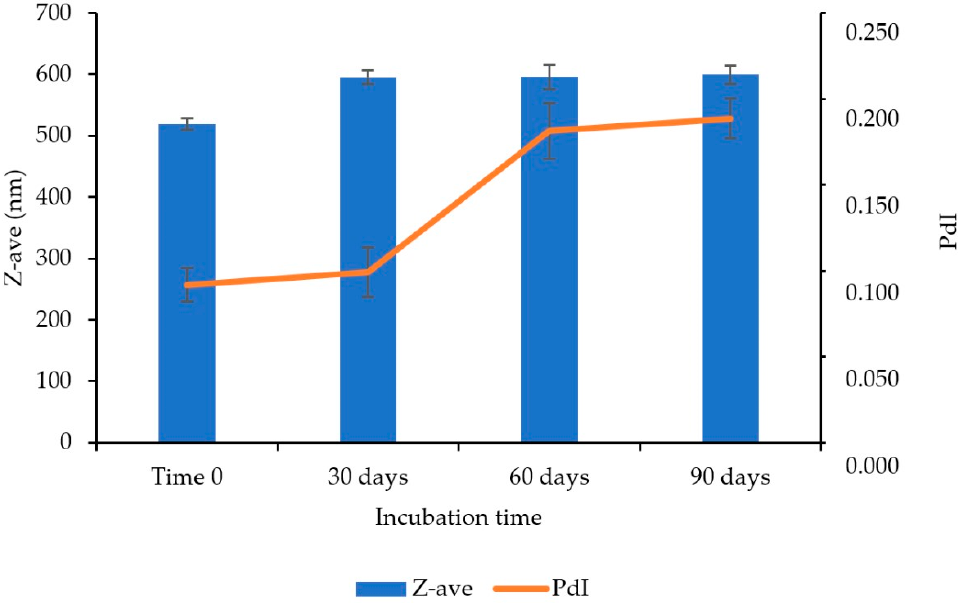
Figure 9. Determination of the average hydrodynamic diameter (Z-ave) in nm and polydispersion index (PdI), for the accelerated stability study of the nanosuspension of besifloxacin 0.6 wt%, in the time intervals: T0, 30, 60, and 90 days. Study condition: 40 °C ± 2 °C/75% RH ± 5% RH. n = 3 batch. Additionally, a monomodal distribution was observed (Figure S6) after 90 days of incubation, with PdI ≤ 0.2, and no statistically significant change ( p -value = 0.22239; α = 0.05) (Figure 9). Similarly, no significant changes were observed in pH ( p -value = 0.78369; α = 0.05) and zeta potential ( p -value = 0.18212; α = 0.05) (Figure 10). Additionally, the con- tent was stable at the end of the period.